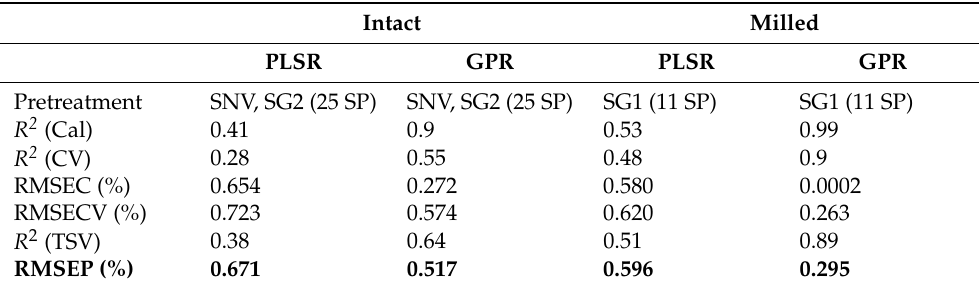
Table 11. The parameters of the regression models constructed for the fused spectral data from the two cost-effective miniaturized NIR spectrometers (Tellspec Enterprise sensor and SCiO sensor) for the analysis of protein content in intact and milled bars. Analyzed protein concentration range: 19.3–23.0 % ( w / w ). Reproduced (CC-BY 4.0 license) from [73]. Intact Milled PLSR PLSR